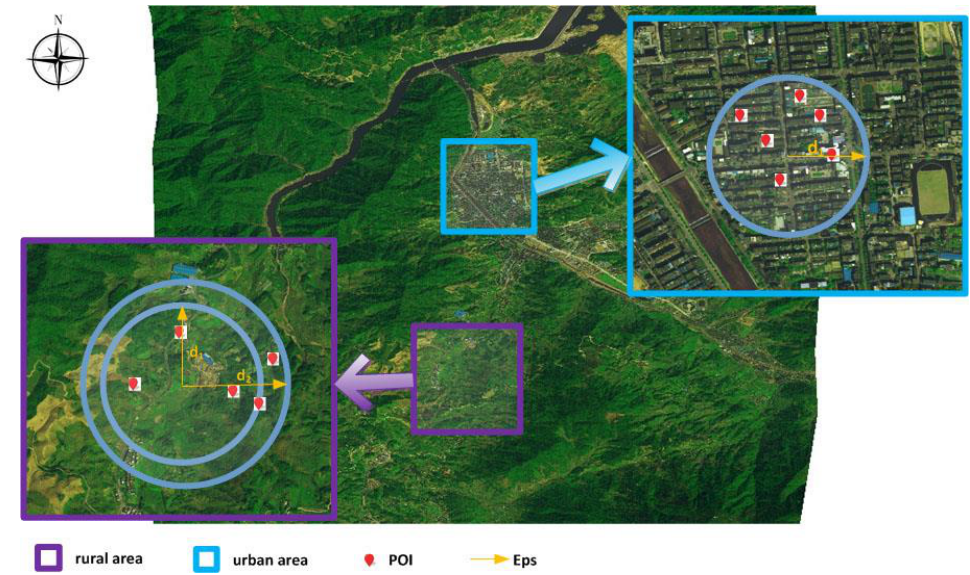
Figure 2. Parameters are inflexible and unreasonably set.